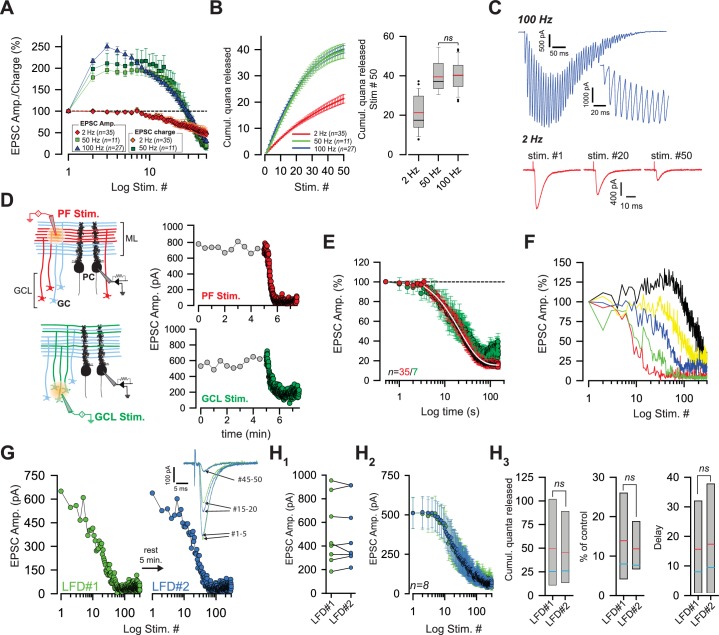
Low-frequency depression at GC-PC synapses.(A) Averaged EPSC amplitude and charge versus stimulus number during train of stimuli at 2, 50 and 100 Hz. At 50 Hz EPSC amplitude and EPSC charge are represented by light and dark green squares, respectively. At 2 Hz, EPSC amplitudes and EPSC charge are represented with red diamonds and orange diamonds, respectively. Note strong facilitation at 50 and 100 Hz, no facilitation at 2 Hz. (B) Left and right panels represent the number of quanta released during trains of 50 stimuli at 2, 50 and 100 Hz. Left panel: Cumulative number of quanta release versus stimulus number at 2 Hz (red line), 50 Hz (green line) and 100 Hz (blue line). Note that the superposition of values at 50 Hz and 100 Hz mask the values at 100 Hz. Right panel: Box-plots showing the corresponding cumulative number of quanta released at the 50th stimulus. No difference was observed between 50 and 100 Hz (t-test, p=0.82). Mean and median values are indicated in red and black, respectively. (C) Representative recording traces of EPSCs evoked at 100 Hz and 2 Hz. Inset: The first EPSCs observed during 100 Hz train. The stimulus artifacts have been subtracted for the 100 Hz train. (D) left, schematics showing the two modes of stimulation. Extracellular stimulations in the molecular layer (ML) (upper panel) activated beams of PFs (in red) whereas stimulations of the granule cell layer (GCL) (lower panel) led to sparse activations of PFs (in green) Non-stimulated GCs are represented in light blue. Stimulated areas are represented by concentric orange circles. Right, two examples of the time course of EPSC amplitudes following stimulation of PFs (upper panel) or of GC somata (lower panel) at 0.033 Hz (gray points) and 2 Hz (red or green points respectively). (E) Mean normalized EPSC amplitude during sustained 2 Hz stimulations of PFs or GC somata (red and green points respectively). Note the delay before the actual induction of LFD. The depression was fitted by a monoexponential function (tau = 21.7 s, white line). (F) Selected time course of LFD recorded in 5 PCs showing differences in the onset and the plateau of depression. (G, H) LFDs elicited in the same cell share the same profile of depression. (G) Time courses of two successive LFDs elicited in the same cell. The second LFD protocol (LFD#2, blue points) was performed after a resting period of 5 min (LFD#1, green points). inset, traces correspond to averaged EPSCs recorded during LFD#1 and LFD#2 (green and blue traces, respectively) at the indicated stimulus numbers. (H1) EPSC amplitudes recorded at the first stimulus of LFD#1 (green points) and LFD#2 (blue points). The similar sizes of EPSC amplitudes in LFD#1 and LFD#2 indicates full recovery from depression during the resting period (paired t-test performed on EPSCs#1 of LFD#1 and LFD#2, p=0.94, n = 8). (H2) Superimposition of mean EPSC amplitudes recorded during LFD#1 (green points) and LFD#2 (blue points). Same set of experiment as in H1. (H3) Box-plots showing the cumulative number of quanta released during LFD#1 and LFD#2 (number of quanta released during LFD: 49.5 quanta ± 18.8 quanta for LFD#1 versus 45.6 quanta ±, 14.5 quanta for LFD#2, paired t-test, p=0.47, n = 8), the plateau of LFD#1 and LFD#2 (mean percentage of initial response for LFD: 13.9 ± 5.2% for LFD#1 versus 11.8% ±, 3.2 for LFD#2, paired t-test, p=0.39, n = 8) and the delay before the onset of depression (15.6 stimuli ± 6.6 stimuli for LFD#1 versus 17.4 stimuli ± 7.2 for LFD#2. paired t-test, p=0.13, n = 8). Since none of these parameters were statistically different between the two conditions, LFD#1 and LFD#2 were considered identical. Blue and red lines indicate median and mean values respectively. Same set of experiments as in H1, H2.